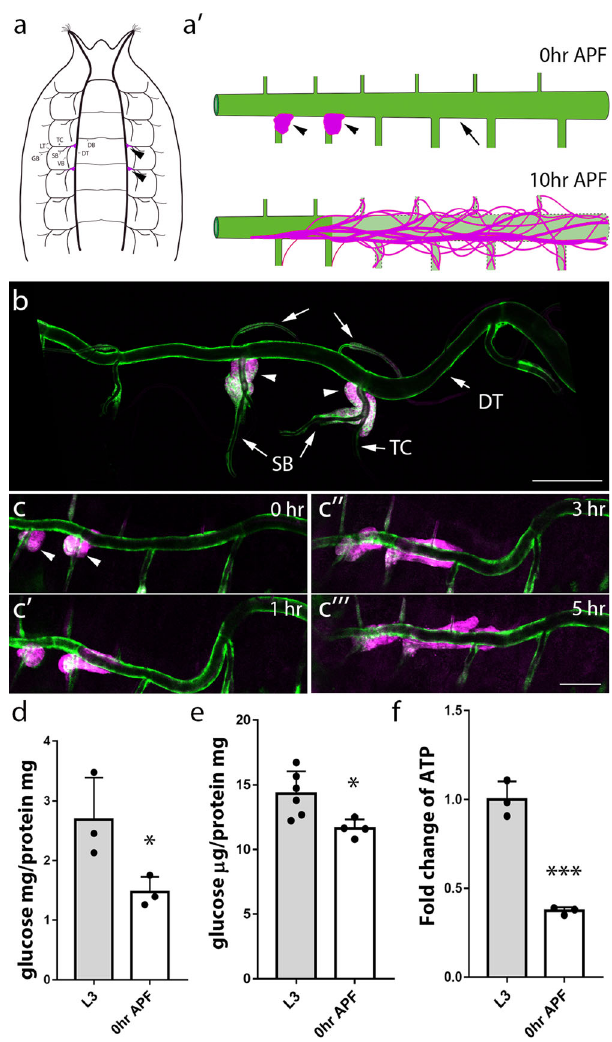
Fig. 1 The activated tracheal progenitors migrating during pupariation. a Schematic diagram depicting the localization of progenitors (magenta) and trachea in a white pupa (0 h APF). Arrows denote dorsal trunk (DT), dorsal branch (DB), transverse connective (TC), visceral branch (VB), spiracular branch (SB), lateral trunk (LT), and ganglionic branches (GBs). Arrowheads point to tracheal progenitors (magenta). a ’ Schematic representation of trachea (green) and progenitors (magenta) at 0 h APF or 10 h APF. Activated progenitors move posteriorly along the dorsal trunk. The posterior tracheal branches outlined by dashed lines are replaced by tracheal progenitors. b The larval tracheal branches are visualized by membrane-tethered GFP under the control of Dl-Gal4 driver. Arrows denote dorsal trunk (DT), dorsal branch (DB), transverse connective (TC) and spiracular branch (SB). Arrowheads point to tracheal progenitors (magenta) that reside on Tr4 and Tr5 metameres. c – c ”’ Migration of tracheal progenitors (magenta, arrowheads) along the dorsal trunk at indicated ages. b , c Three independent experiments were repeated with similar results. d Bar graph represents the systemic level of glucose in L3 and 0 h APF fl ies ( n = 60 for all groups). Three biological replicates were performed. * p = 0.0478. e Bar graph represents the level of glucose in the trachea of L3 larvae ( n = 120) and white pupae (0 h APF) ( n = 80). Four biological replicates were performed. * p = 0.0205. f Bar graph plots the relative abundance of tracheal ATP in L3 larvae and white pupae (0 h APF) ( n = 60 for all groups). Three biological replicates were performed. ** p = 4.63e-4. d – f Data are presented as mean values ± SD. Unpaired two- tailed t -test was used for all statistical analyses. No adjustments were made for multiple comparisons. Scale bars: 150 μ m ( b – c ”’ ). Genotype: ( b – c ”’ ) UAS-CD8:GFP; Dl-Gal4, P[B123]-RFP-moe . Source data for ( d , e , f ) are provided as a Source Data fi